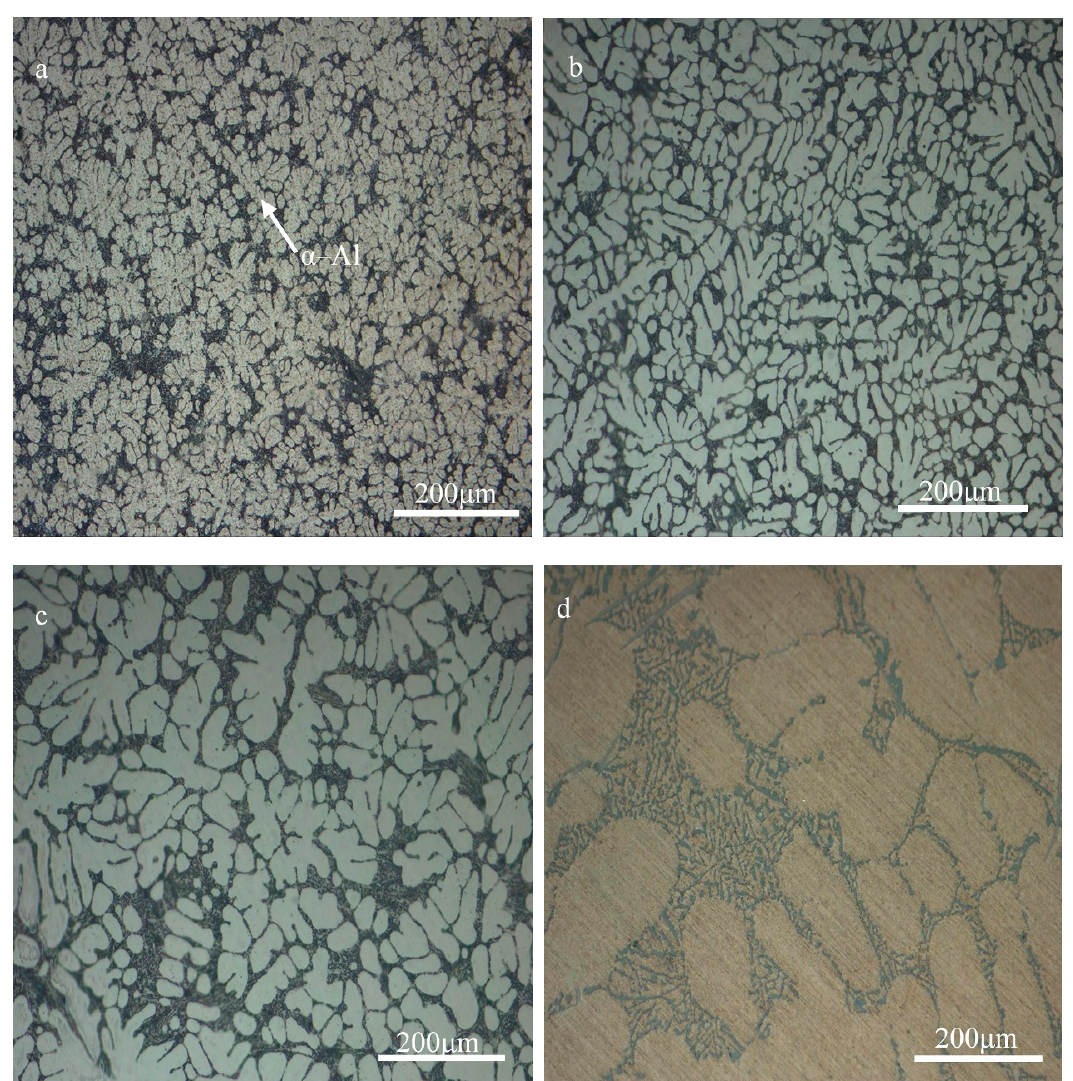
Figure 2. Optical microstructures of Al matrix nanocomposites and the matrix alloy: ( a ) 2 wt.% SiC np /Al 2 O 3np /Al; ( b ) 2 wt.% SiC np /Al; ( c ) 2 wt.% Al 2 O 3np /Al; and ( d ) A356.